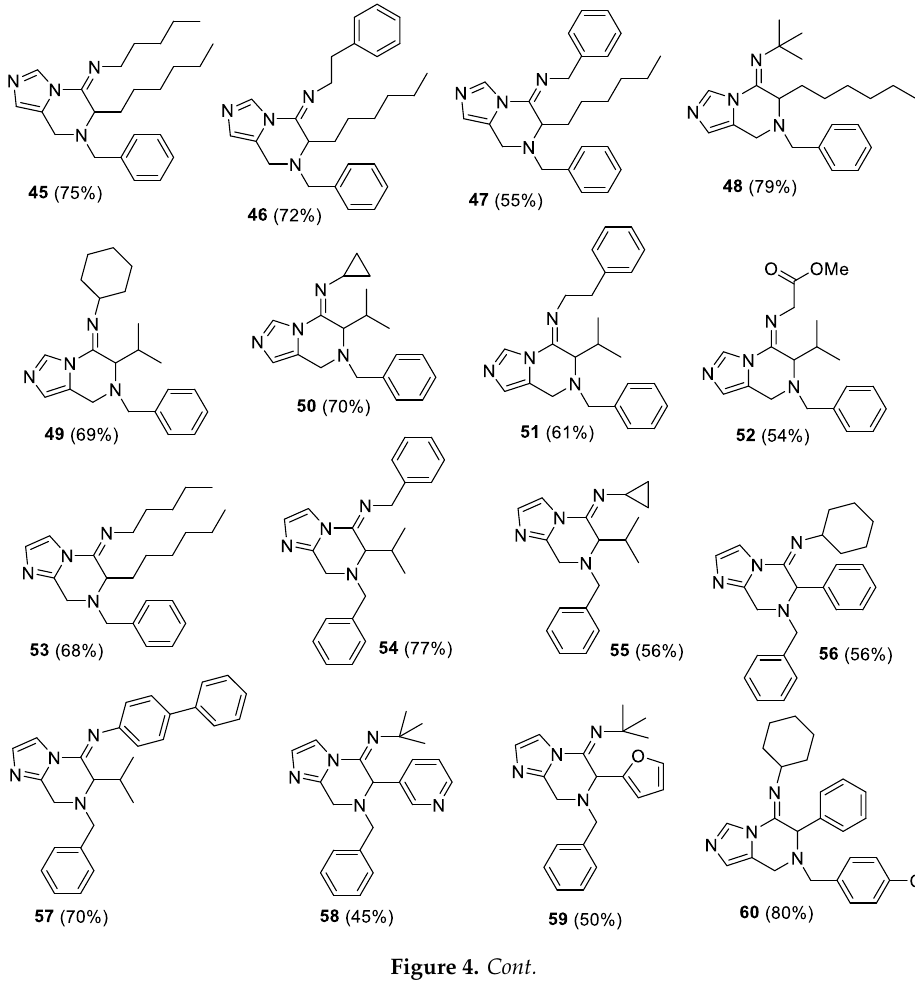
Figure 4. Figure 4. Synthesized imidazopyrazines.